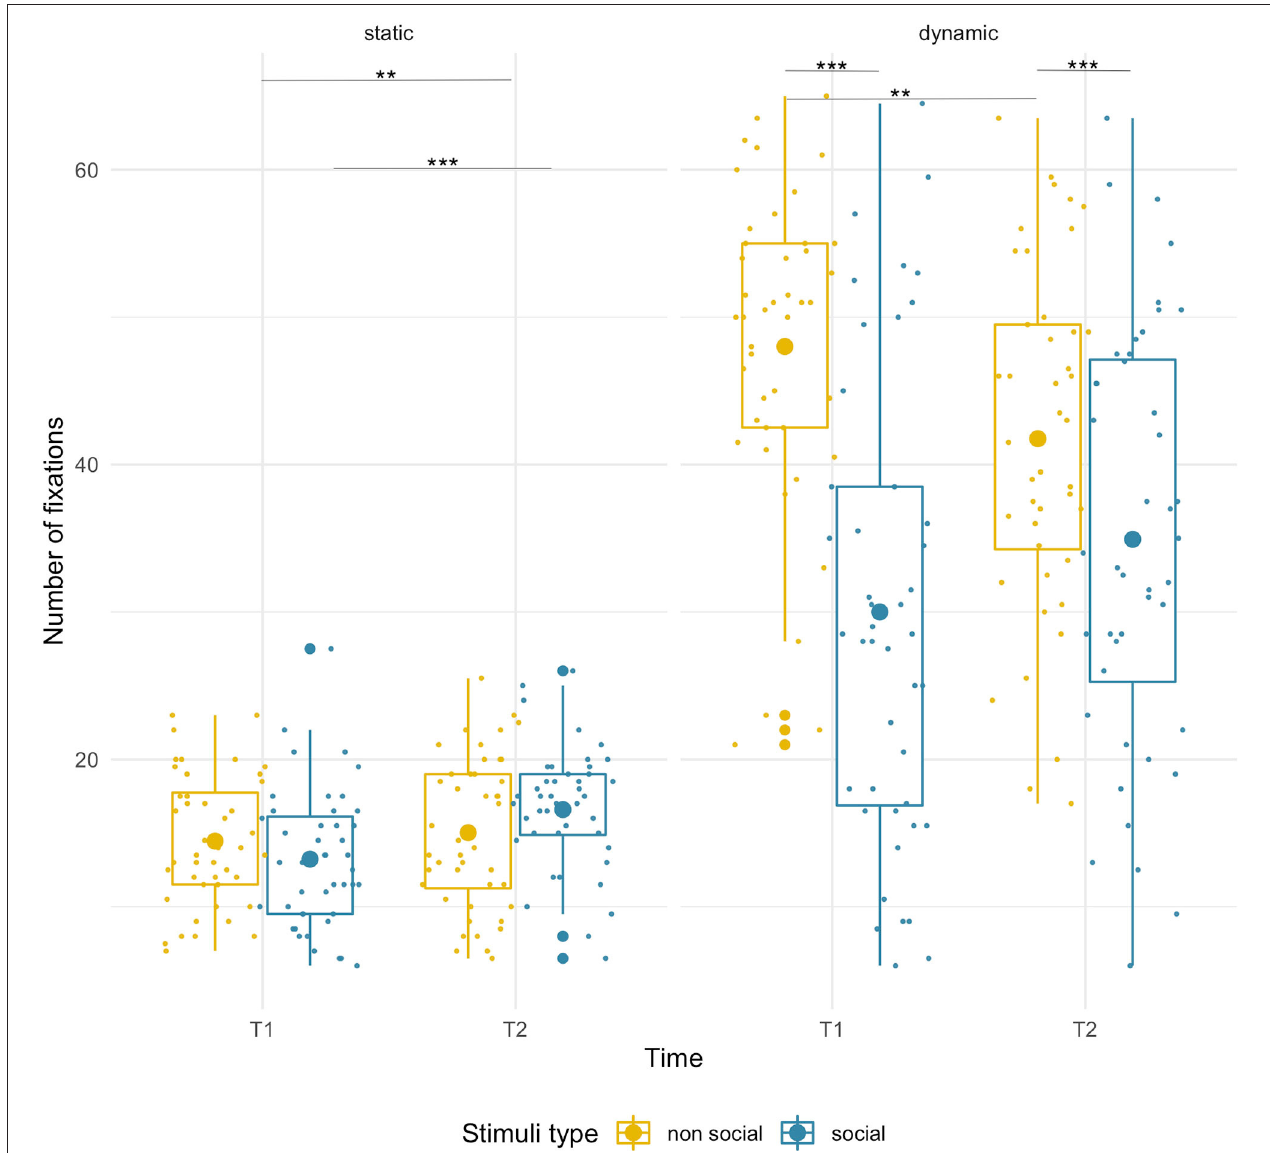
FIGURE 6 | Box plots with individual data showing distribution of the number of fixations for each stimulus type. The big dot inside each box indicates the mean value of number of fixations. Fewer fixations for static stimuli were due to shorter presentation time. Significant differences marked with asterisks: ** p < 0.01; *** p < 0.001.